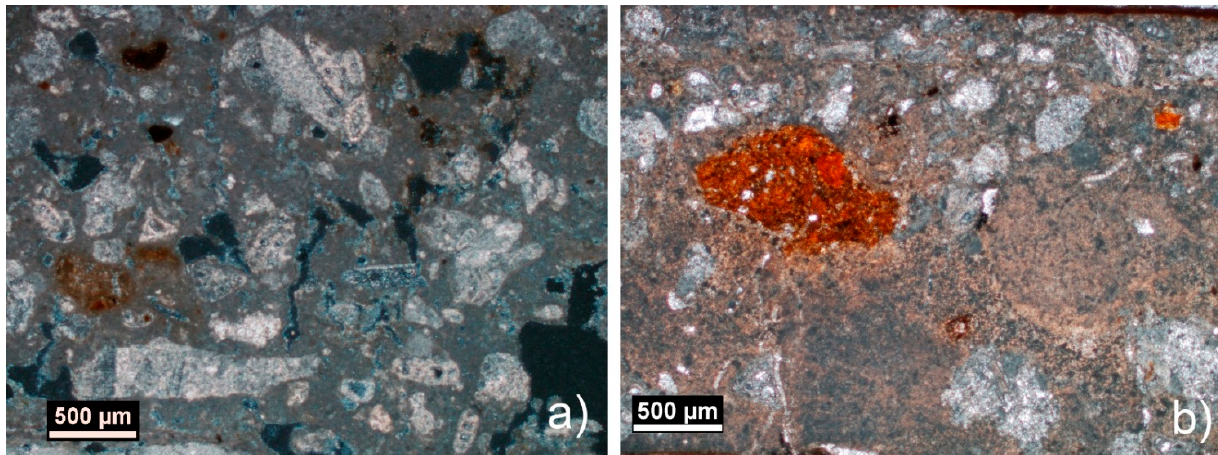
Figure 10. Transmitted-light optical microscope microphotographs in thin sections showing: ( a ) the preparatory mortar composed by cryptocrystalline calcite binder and the aggregate consisting of carbonate rock fragments and minor quartz and feldspars, and ( b ) lime lumps and cocciopesto fragments to increase the hydraulic properties of preparatory mortars.